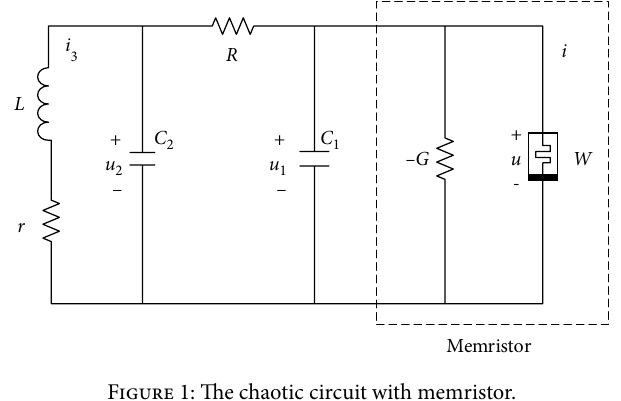
Figure 1: The chaotic circuit with